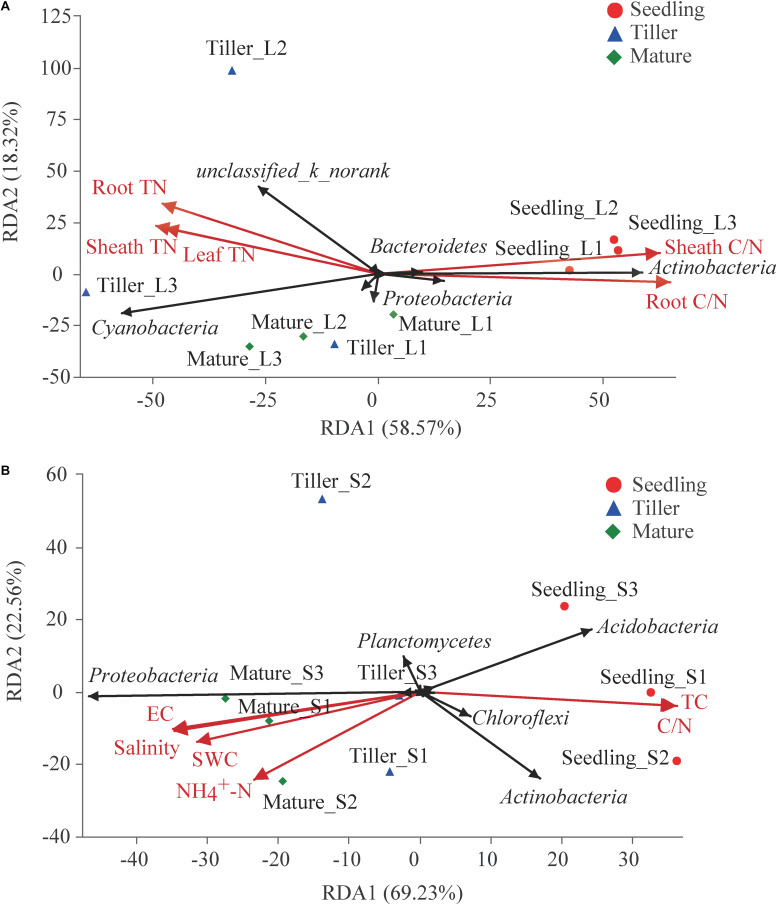
Redundancy analysis (RDA) analysis of the top 10 bacterial phyla and leaf or soil characteristics. Phyllosphere and rhizosphere bacterial communities are shown in (A,B), respectively. The values of axes 1 and 2 are the percentages explained by the corresponding axis.